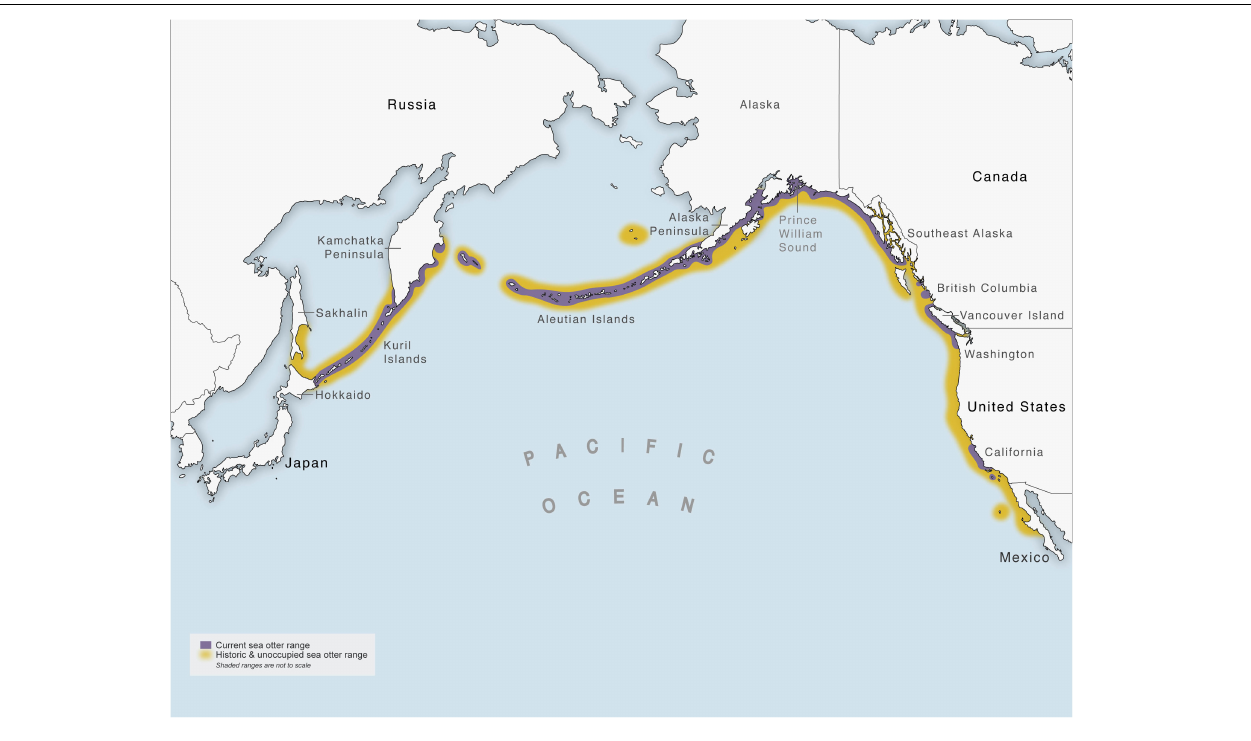
FIGURE 2 | Current (purple) and historic (yellow) sea otter